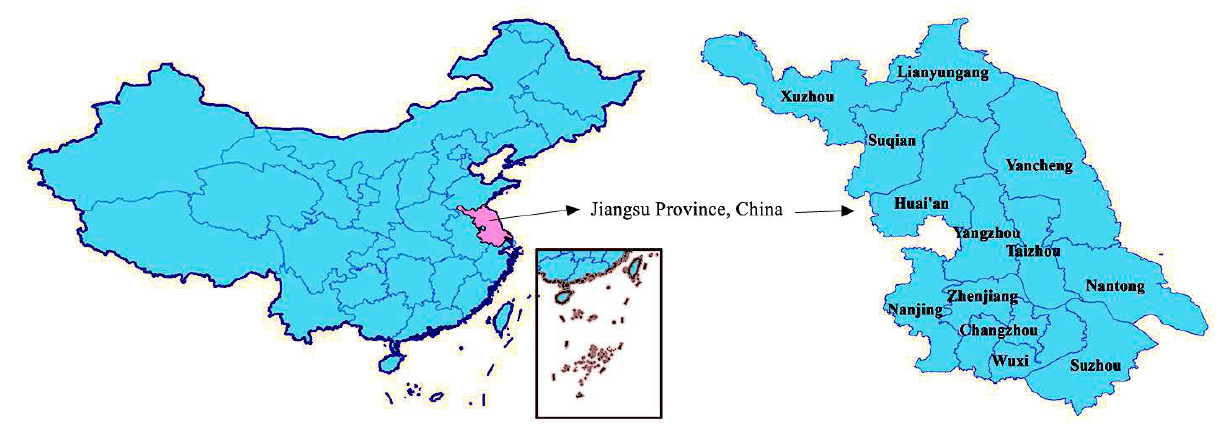
Figure A1. Geographical location and administrative division map of Jiangsu Province.